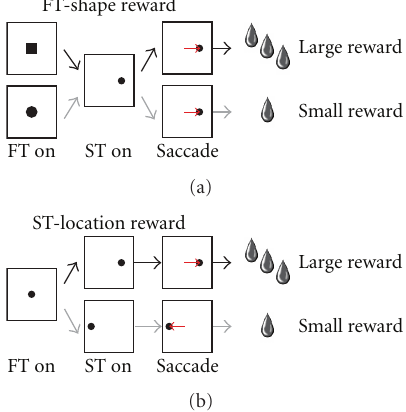
Figure 2: Schematic diagrams for the two-valued reward saccade tasks. (a) The reward magnitude was cued by the shape of the initial central fixation target (square or circle) for recordings from PPTN neurons. (b) The location of the saccade target (left or right) was associated with large or small rewards, respectively, in recordings from DRN neurons. FT: fixation target, ST: saccade